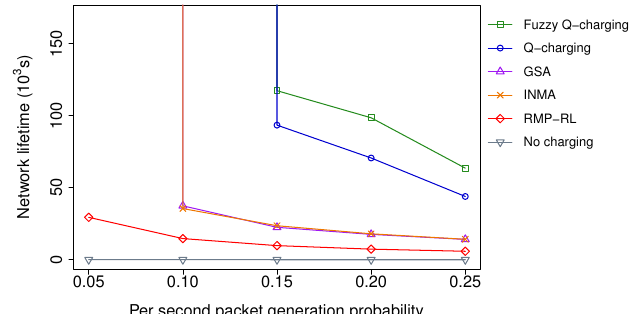
Figure 9. Network lifetime vs. the packet generation frequency.